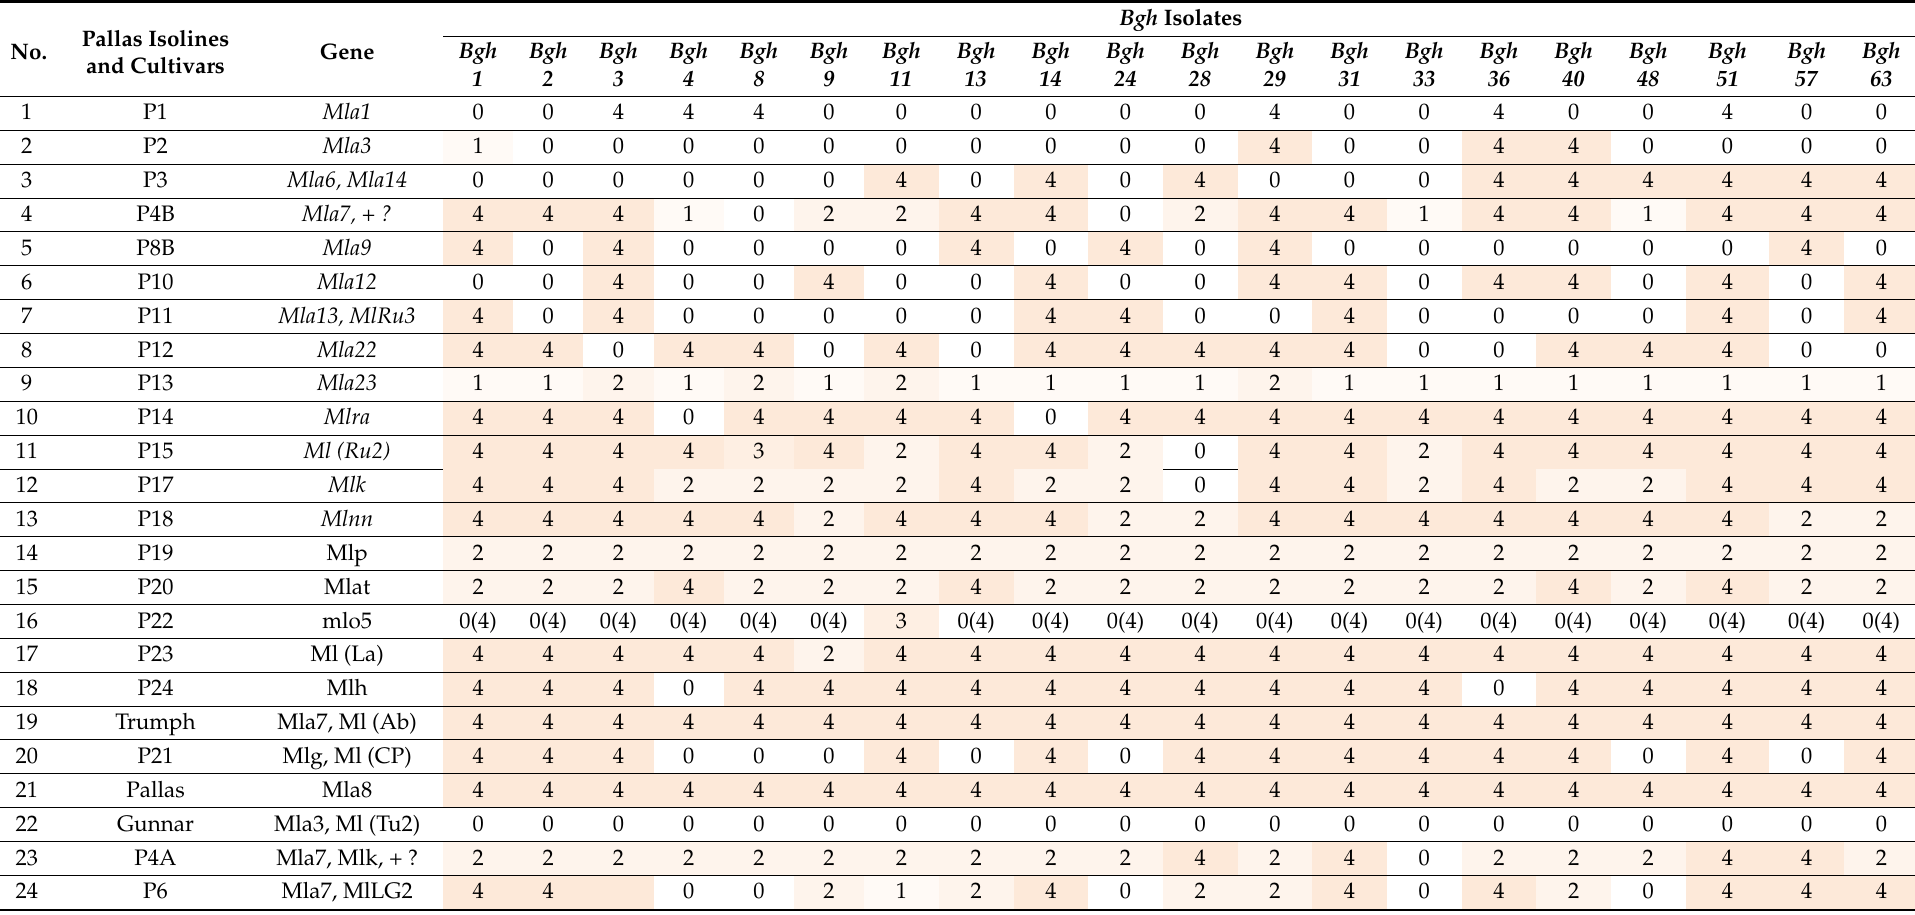
Table 2. B. graminis f. sp. hordei isolates used for artificial inoculation and their virulence spectra against resistance genes on differential set of Pallas near-isogenic lines and 11 cultivars. Pallas No.